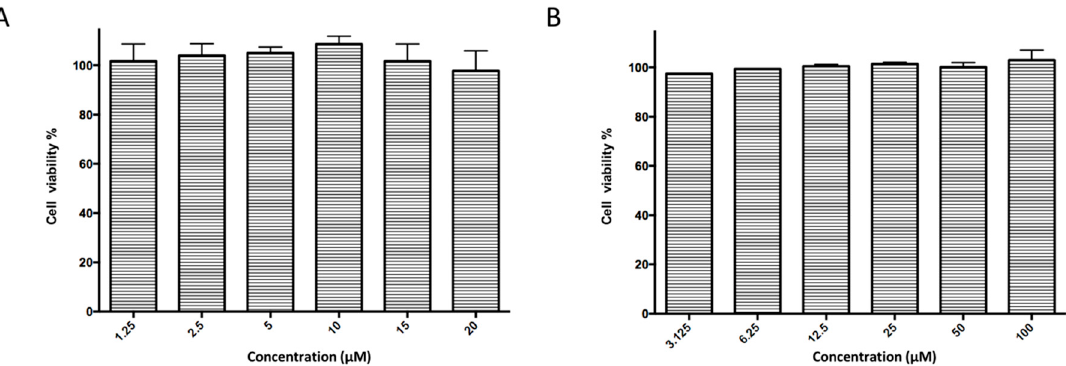
Figure 4. Examination of any cytotoxicity of Compounds 1 and 2 . Percent cellular viability was measured for ( A ) Compound 1 under a gradient concentration from 1.25 μ M to 20 μ M. ( B ) Compound 2 under a gradient concentration from 3.125 μ M to 100 μ M on BHK-21 cell lines.